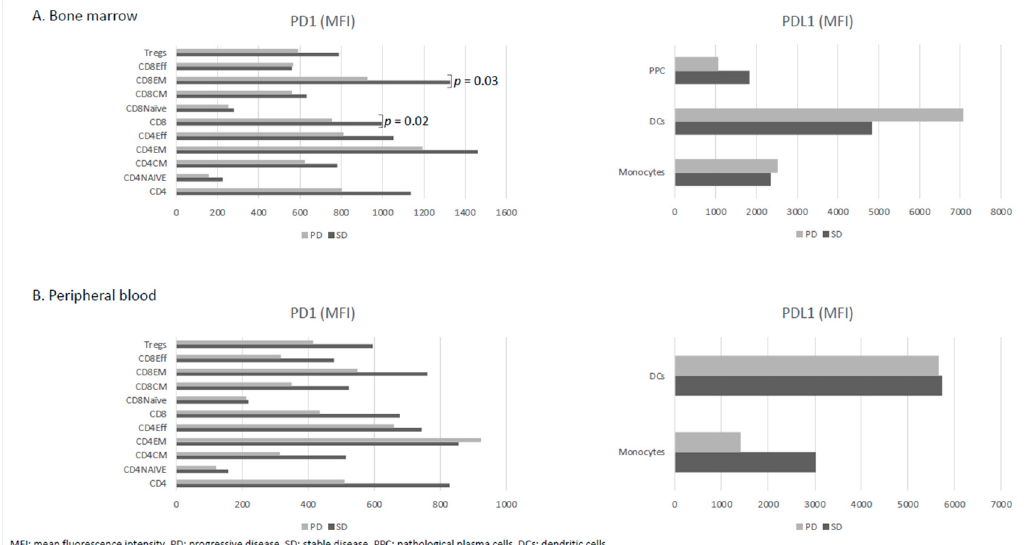
Figure 3. (A , B) Baseline PD1/PDL1 expression in the corresponding immune cell populations according to the patient ’ s behavior after treatment with pembrolizumab. PD1/PDL1 expression is represented as the mean fluorescence intensity (MFI) obtained in each cell population; “early progressing” patients are depicted with light-gray bars (PD) and “stable” patients are depicted with dark-gray bars (SD). Only statistically significant p -values are detailed.